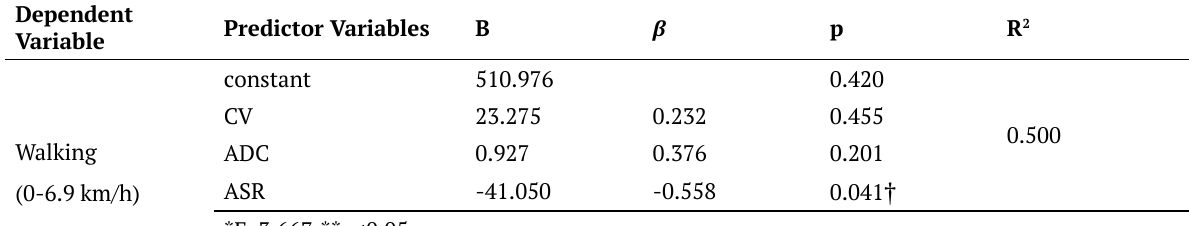
Table 4. Multiple Linear Regression Analysis Results Regarding the Effects of Critical Velocity, Anaerobic Distance Capacity and Anaerobic Speed Reserve on Match Running Profile